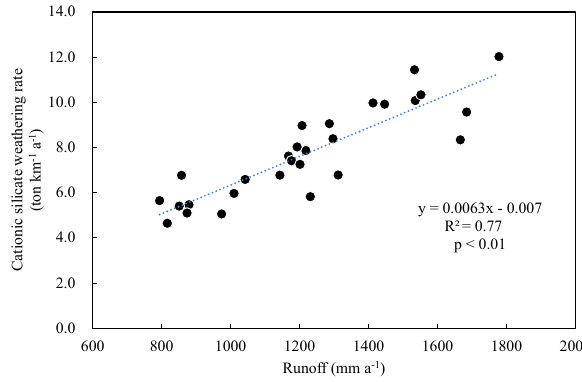
Figure 5. Plots of the cationic–silicate weathering rate (Cat sil ) vs. runoff for the